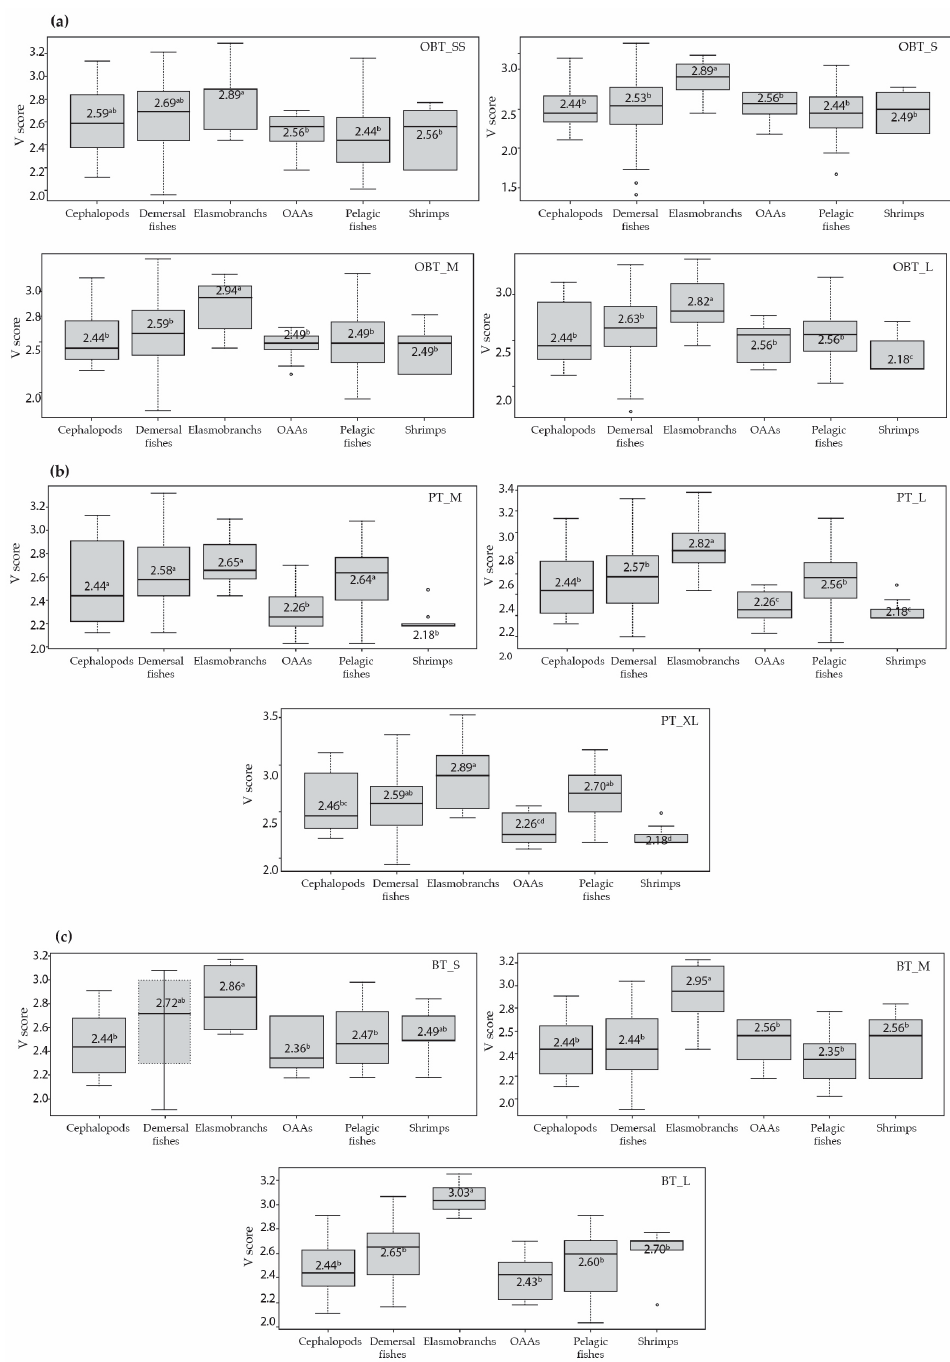
Figure 4. Boxplots showing vulnerability scores of taxonomic groups to trawl fisheries in the Gulf of Thailand by trawl type and vessel size. OAAs = Other aquatic animals. Trawl type: ( a ) OBT = Otter-board trawl, ( b ) PT = Pair trawl and ( c ) BT = Beam trawl. Vessel size: SS (<10 gross tonnage, GT), S (10–29.9 GT), M (30–59.9 GT), L (60–149.9 GT) and XL (>150 GT). For each boxplot, the bold line in the center represents the median, the top and bottom of the box represent the first and third quartiles, and the whiskers indicate the highest and lowest values within 1.5 × the interquartile range. Median values are presented and compared among groups within the trawl type and vessel size, where different superscripts indicate significant difference ( p < 0.05) by Dunn’s post